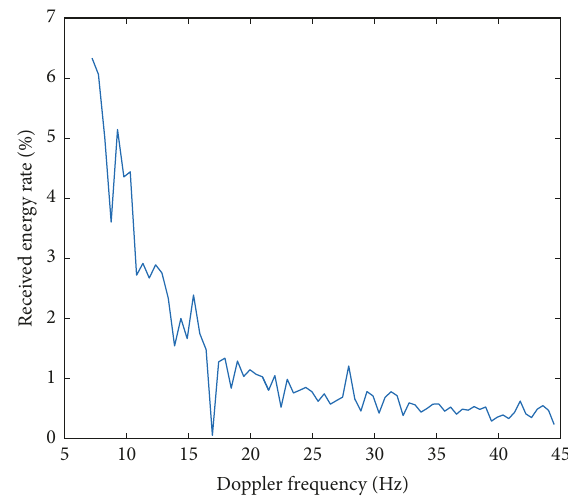
Figure 7: Simulation result when 𝑁 = 5000